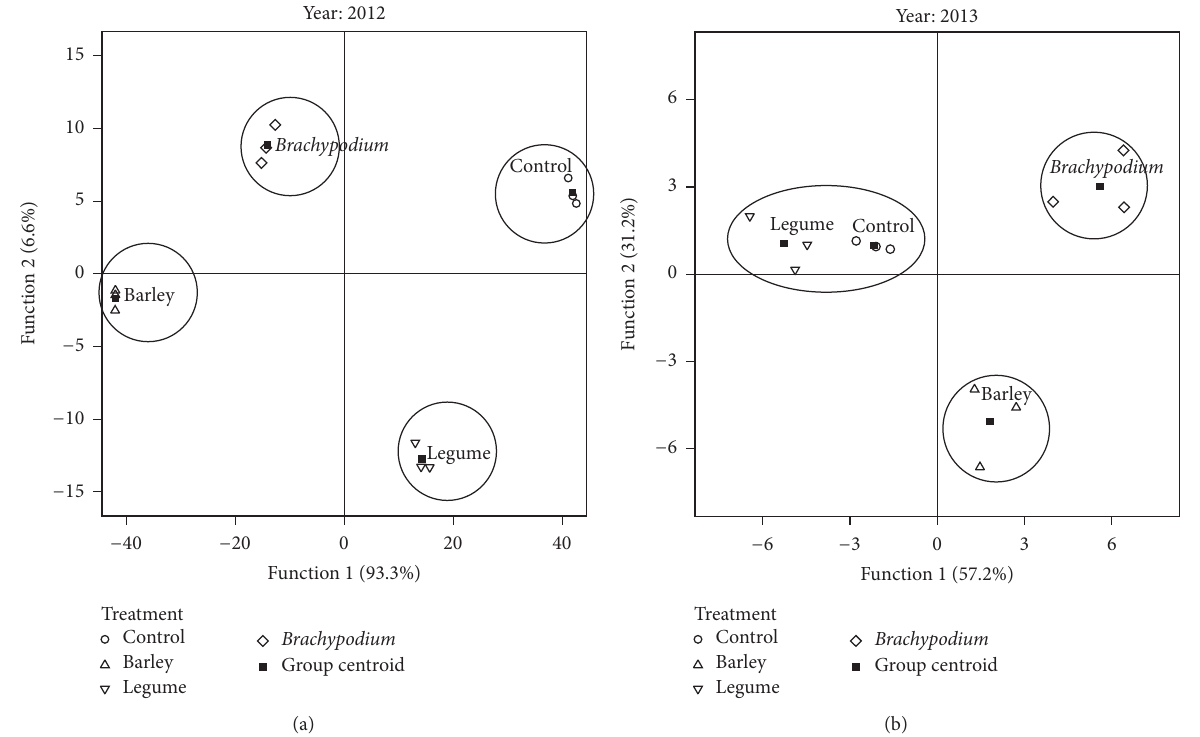
Figure 7: Canonical discriminant functions of the VOOs from different treatments in 2012 (a) and 2013 (b). Amount of variability explained by each function in brackets.